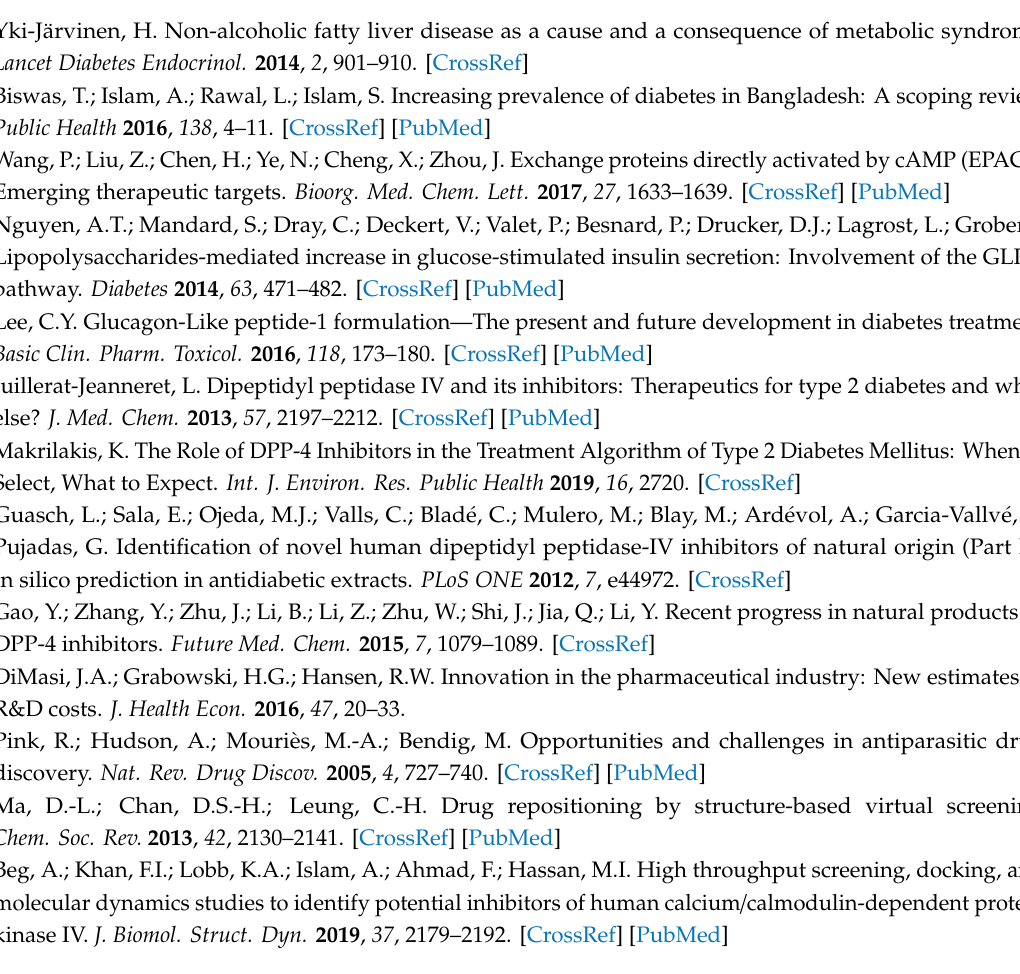
of Moringa oleifera (MO) used in the virtual screening in this